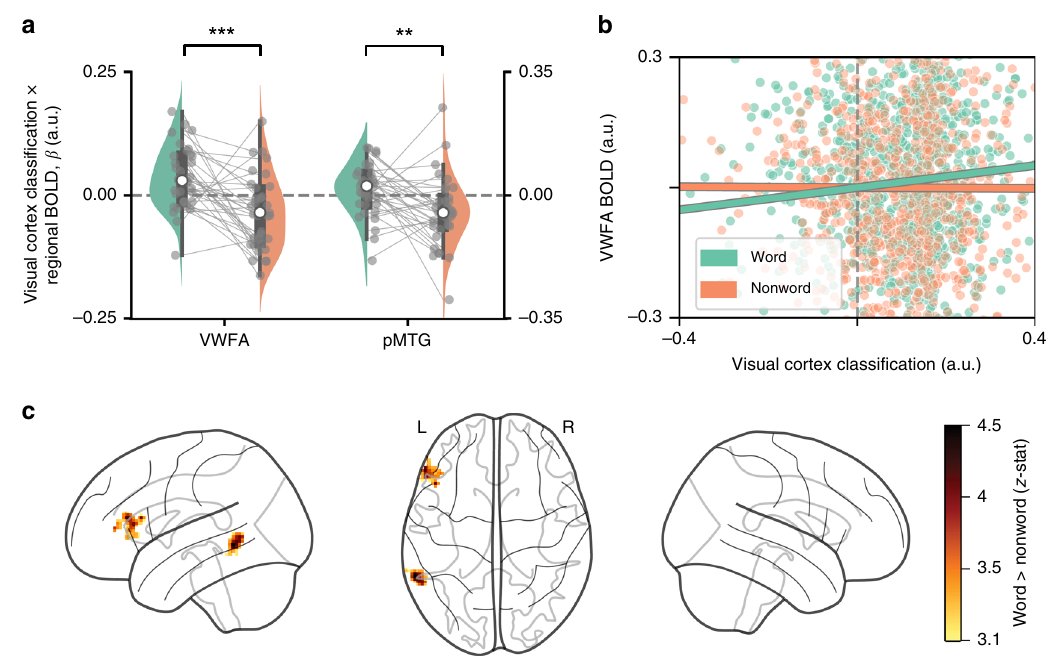
Fig. 4 Information-activation coupling analysis. a ROI-based coupling analysis. For two ROIs, GLMs were fi tted to estimate coupling between early visual cortex classi fi cation evidence and regional BOLD amplitude for words and nonwords separately. We then tested for increased coupling (higher coef fi cients) in words compared to nonwords. b Illustration for example participant. A single (averaged) timecourse was extracted from each ROI and regressed against visual cortex classi fi cation evidence to test for increased slopes in words compared to nonwords. For illustration purposes, only the predicted slopes based on the regressor of interest are shown. Note that classi fi cation evidence was de fi ned as probability, but here expressed in arbitrary units due to the whitening operation. c Whole-brain results. Same analysis as in a and visualised in b , but performed for each voxel independently. Resulting contrast images (word- nonword) were tested at the group level for increases in coupling in words compared to nonwords. This revealed statistically signi fi cant clusters ( p <0.05 FWE corrected), in the left pMTG and in the left IFG. Glass brain plot rendered with nilearn 63 . For a non-thresholded slice-by-slice rendering of the whole-brain results in c , see Supplementary Fig. 11. Grey dots indicate coef fi cients of individual participants, and lines the within-subject differences; white dots, boxes and whiskers are between-subject medians, quartiles and interquartile ranges, respectively. Signi fi cance stars correspond to p <0.01 (**) or p <0.001 (***) in a paired two-tailed t -test or Wilcoxon sign rank test. pMTG posterior medial temporal gyrus, IFG inferior frontal